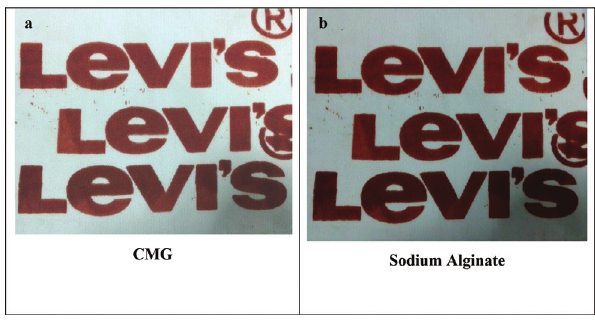
Figure 3: FTIR of (a) native guar gum and (b) carboxymethyl guar gum.